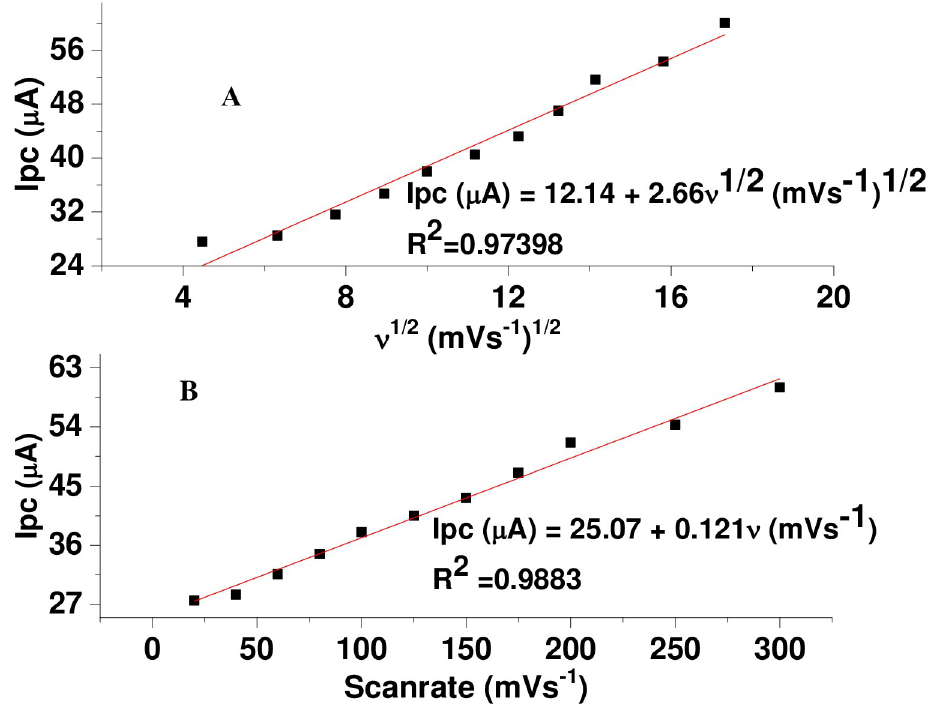
Fig 7. Plot of Ip versus (a) v 1/2 and (b) v for 1.0 mM MTZ in pH 7.0 PBS at PARS/GCE.